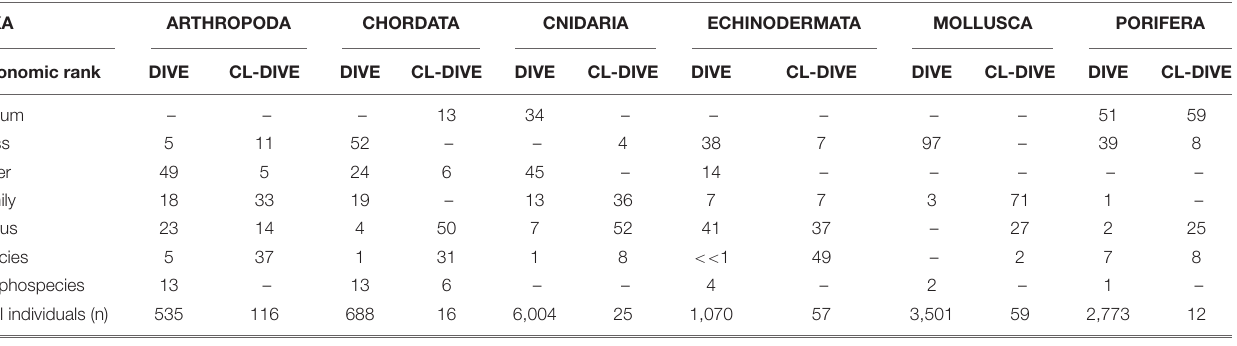
(C) Volcanic island slopes (focus on